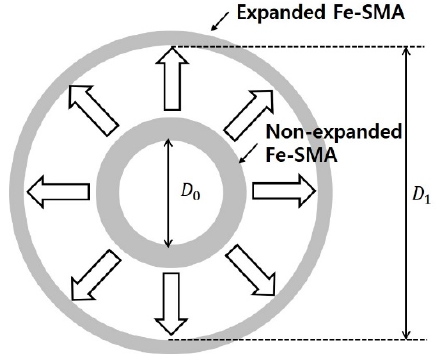
Figure 13. Expanded Fe ‐ SMA coupler for pre ‐ straining.